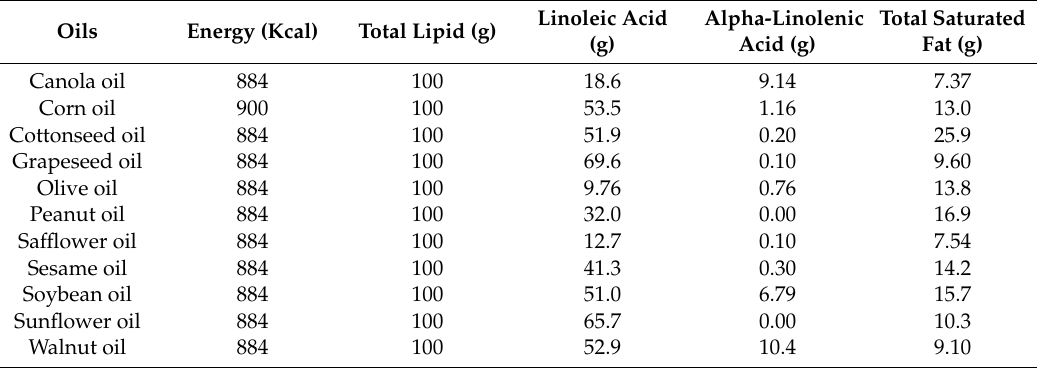
Table 1. Oil sources of linoleic acid (per 100 g) 1